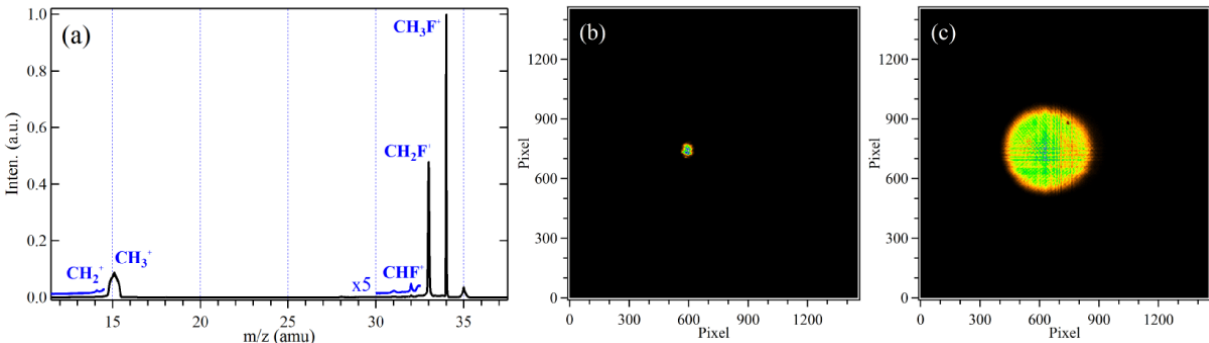
Figure 6. ( a ) Photoionization time-of-flight mass spectrum of CH 3 F, with 5-times-magnified data in blue, ( b ) the CH 3 F + parent ion image, and ( c ) the CH 3+ fragment ion image.